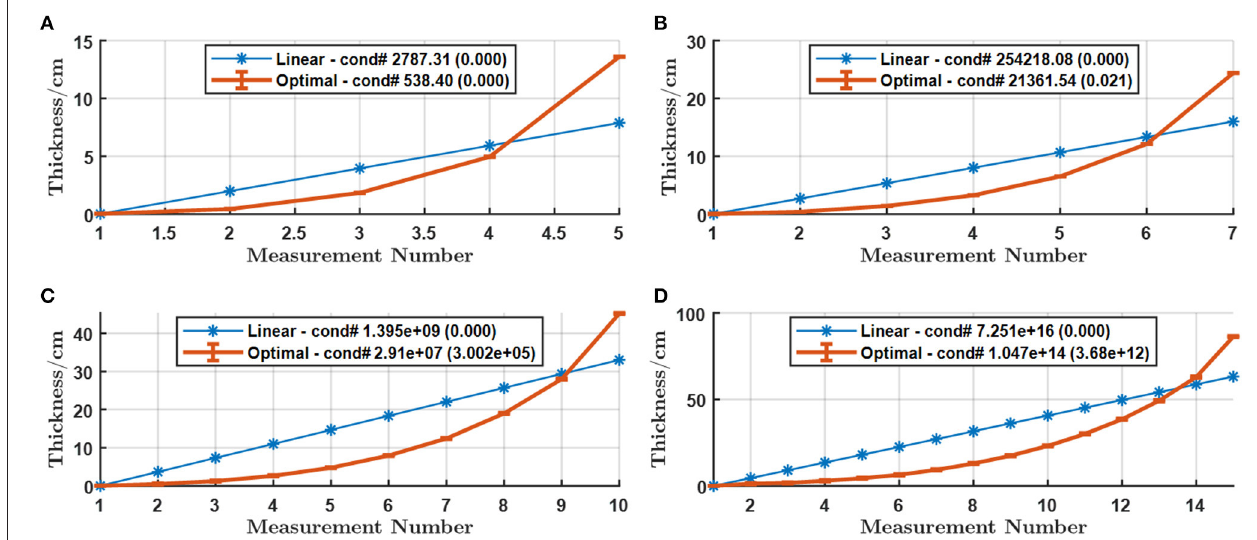
FIGURE 7 | Optimal thickness arrangement against the best linear arrangement for (A) M within [0.02, 100] cm. The error-bars in the curve stand for the standard deviation of the thickness while the number inside parentheses in the legend is the standard deviation of the condition number for 30